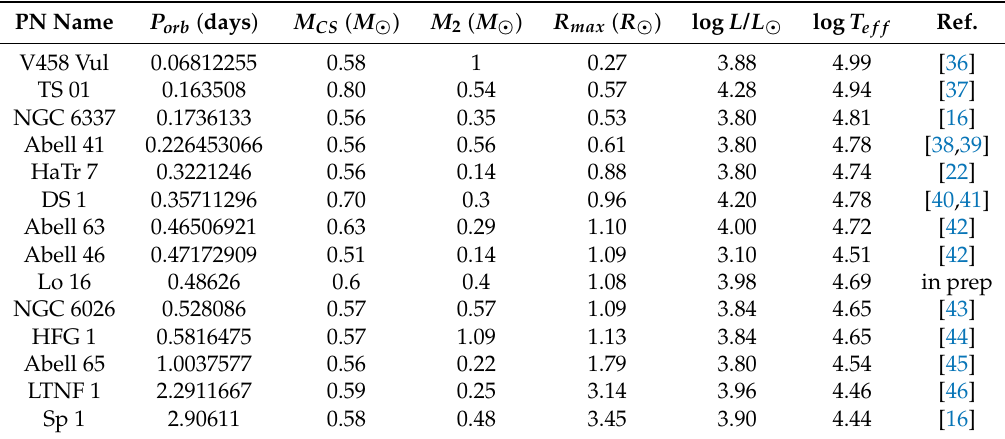
Figure 1. Evolutionary tracks from Table 3 in Miller Bertolami [34] for central stars of planetary nebulae (CSPNe) with Z = 0.01 and for final central star (CS) masses as labeled on the upper-right next to each track. Line styles alternate between sold and dashed to make them easier to follow on the plot. Also shown are the locations of the hot CS of a number of close binary CSPNe at their maximum possible radius (see text for description). Table 1. Literature data for binary CSPNe along with calculated maximum radii and effective temperatures for the CSs at a luminosity appropriate for the CS